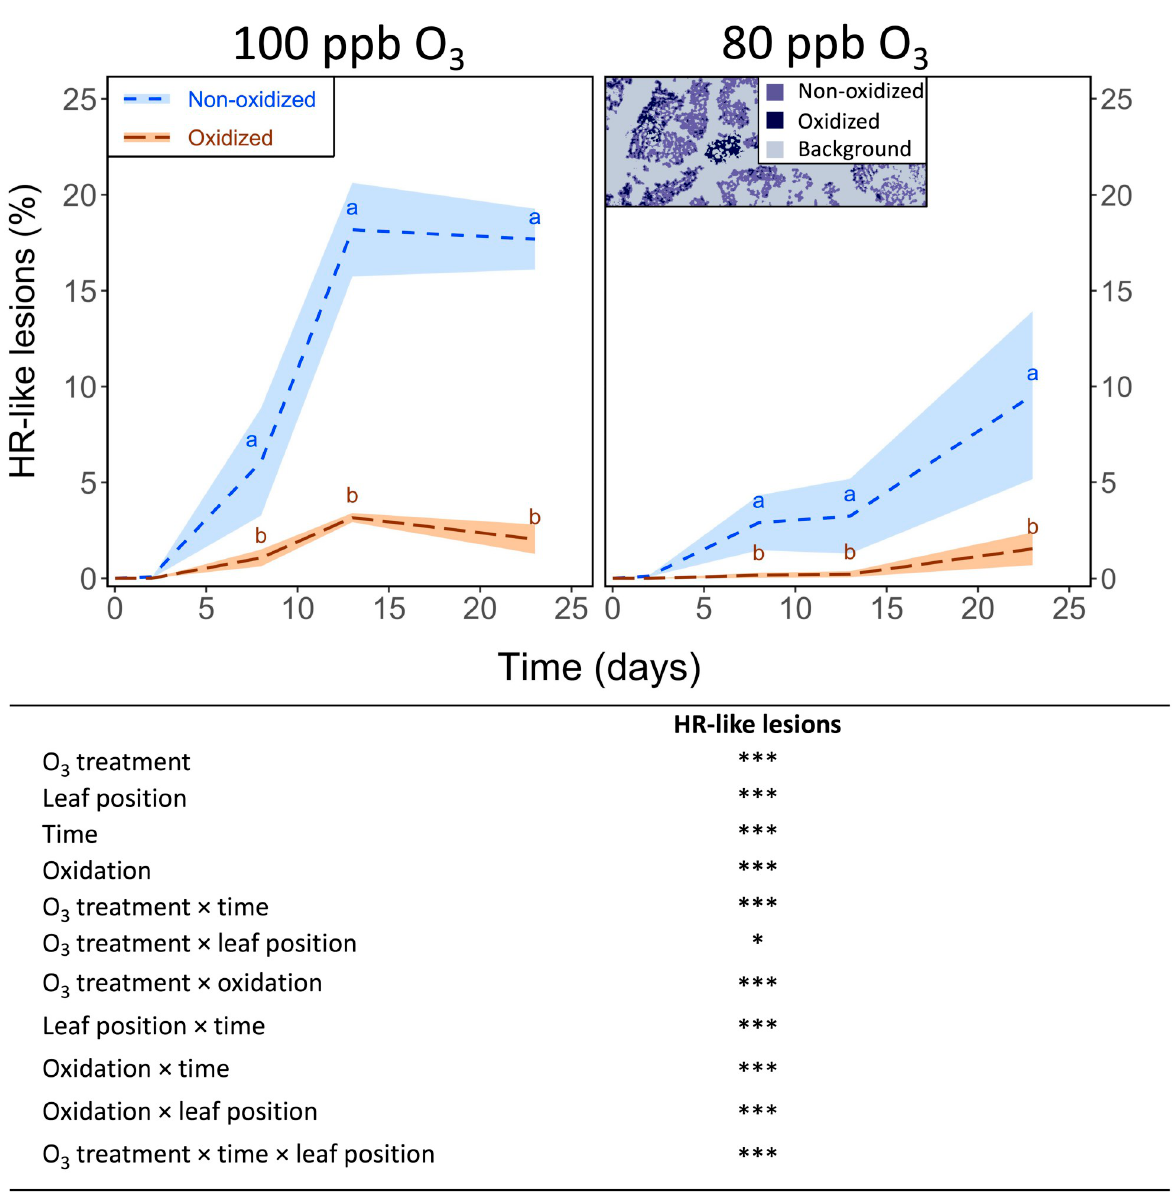
Fig 1. Development dynamics of non-oxidized and oxidized HR-like lesions at the 3 rd leaf position in hybrid poplar ( Populus tremula x alba ), as a function of O 3 treatment and time. {model: lmer[log(variable+1) ~ leaf position � Oxidation � Time � O 3 treatment + (1|pot)]; ��� P � 0.001; � P � 0.05}. The inset image is a synthetic image of the particle distribution and morphology in each lesion color class (non-oxidized/oxidized) during image analyses of HR-like reactions. Values represent percentage area means ± SE of leaf discs showing non-oxidized or oxidized HR-like lesions (n = 4). Different letters indicate significant differences between treatments at a given assessment date (Tukey’s honestly significant difference (HSD) post-hoc test, P � 0.05).